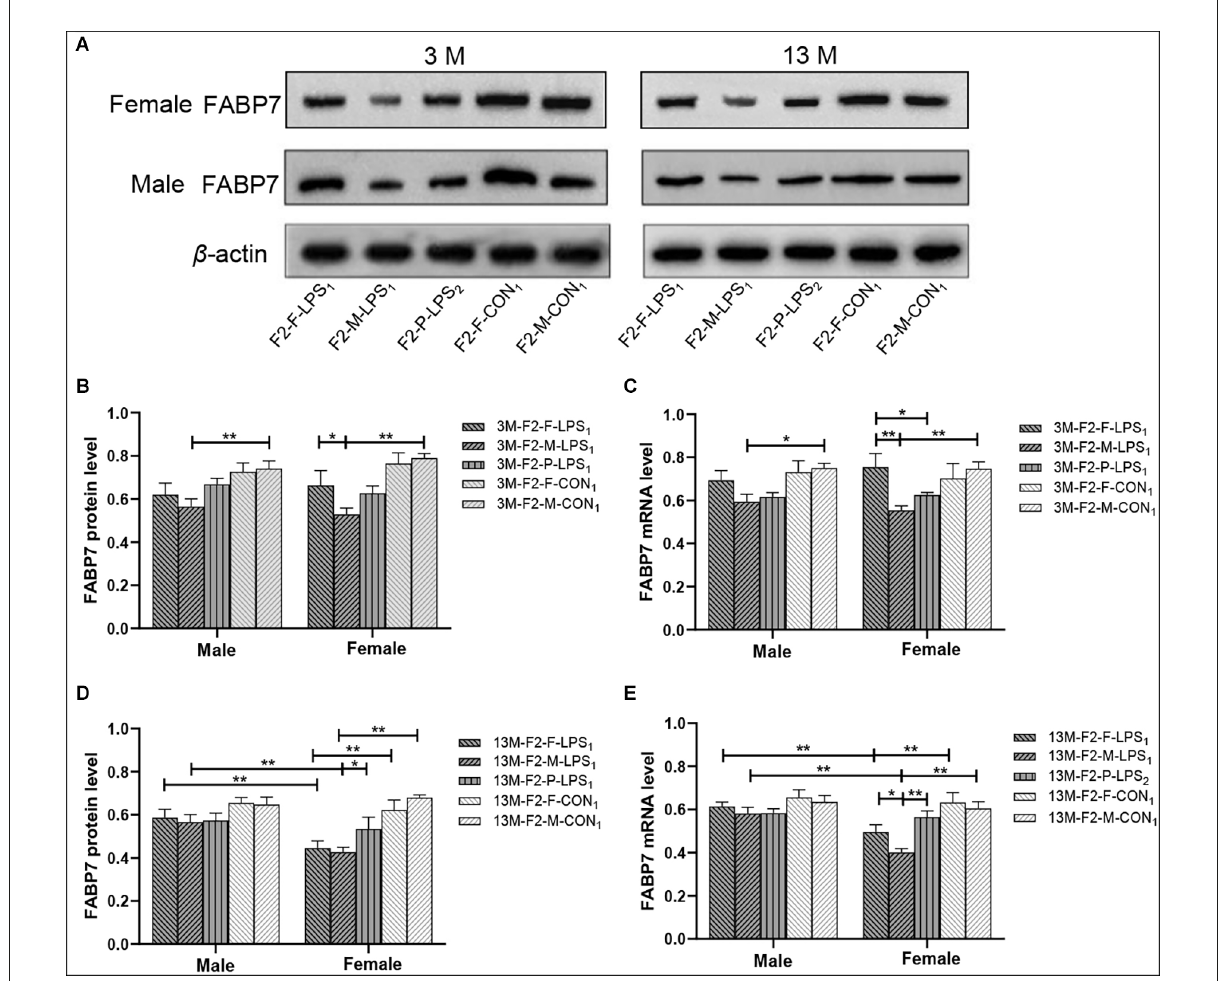
FIGURE7 FABP7 protein and mRNA expression levels in F2 generation mice. (A) Representative FABP7 immunoreactive bands in the hippocampi of F2 mice in the different groups at different ages. (B,D) Hippocampal FABP7 protein levels in 3-month-old (3 M) and 13-month-old (13 M) mice in different groups. (C,E) Hippocampal FABP7 mRNA levels in the 3-month-old (3 M) and 13-month-old (13 M) mice in different groups; n = 6 male or female mice/group. Error bars = standard error of the mean (SEM). * P < 0.05, ** P < 0.01. F2-M-LPS 1 , mice whose mothers were exposed to prenatal inflammation; F2-P-LPS 2 , mice whose parents were exposed to prenatal inflammation; F2-F-LPS 1 , mice whose fathers were exposed to prenatal inflammation; F2-M-CON 1 , mice whose mothers were exposed to saline in utero ; F2-F-CON 1 , mice whose fathers were exposed to saline in utero